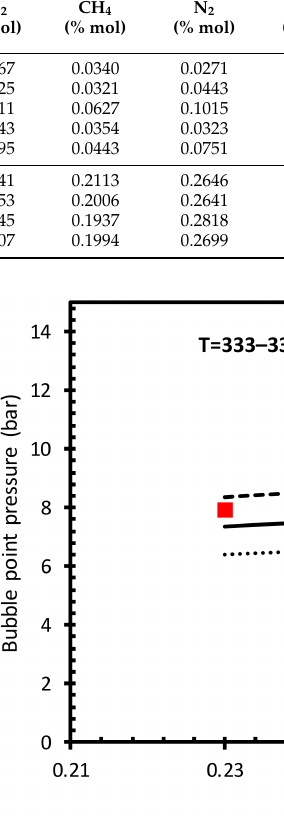
Figure 11. Comparison of the predicted (lines) bubble pressures with those from literature (red symbols) [85] at different values of GLR and NaCl molality.